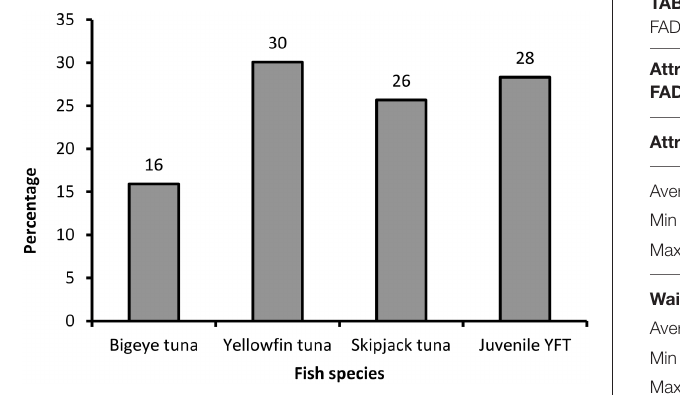
FIGURE 5 | Proportion of occurrence of various tuna species around anchored FADs according to respondents. Numbers are percent of the total interviewees that mentioned given information ( n = 46).